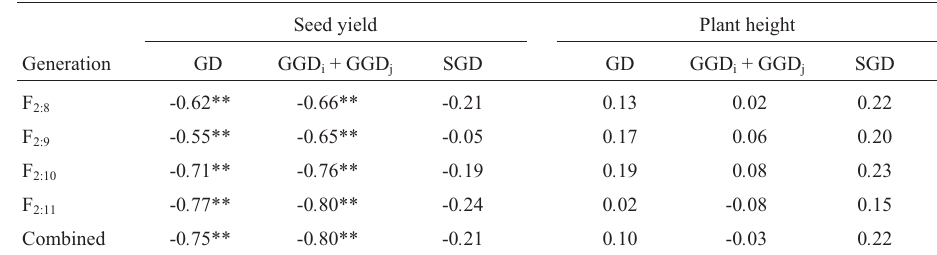
Table 5 - Correlation coefficients between the proportion of superior progenies (PS) and genetic distances (GD), the sum of general genetic distances